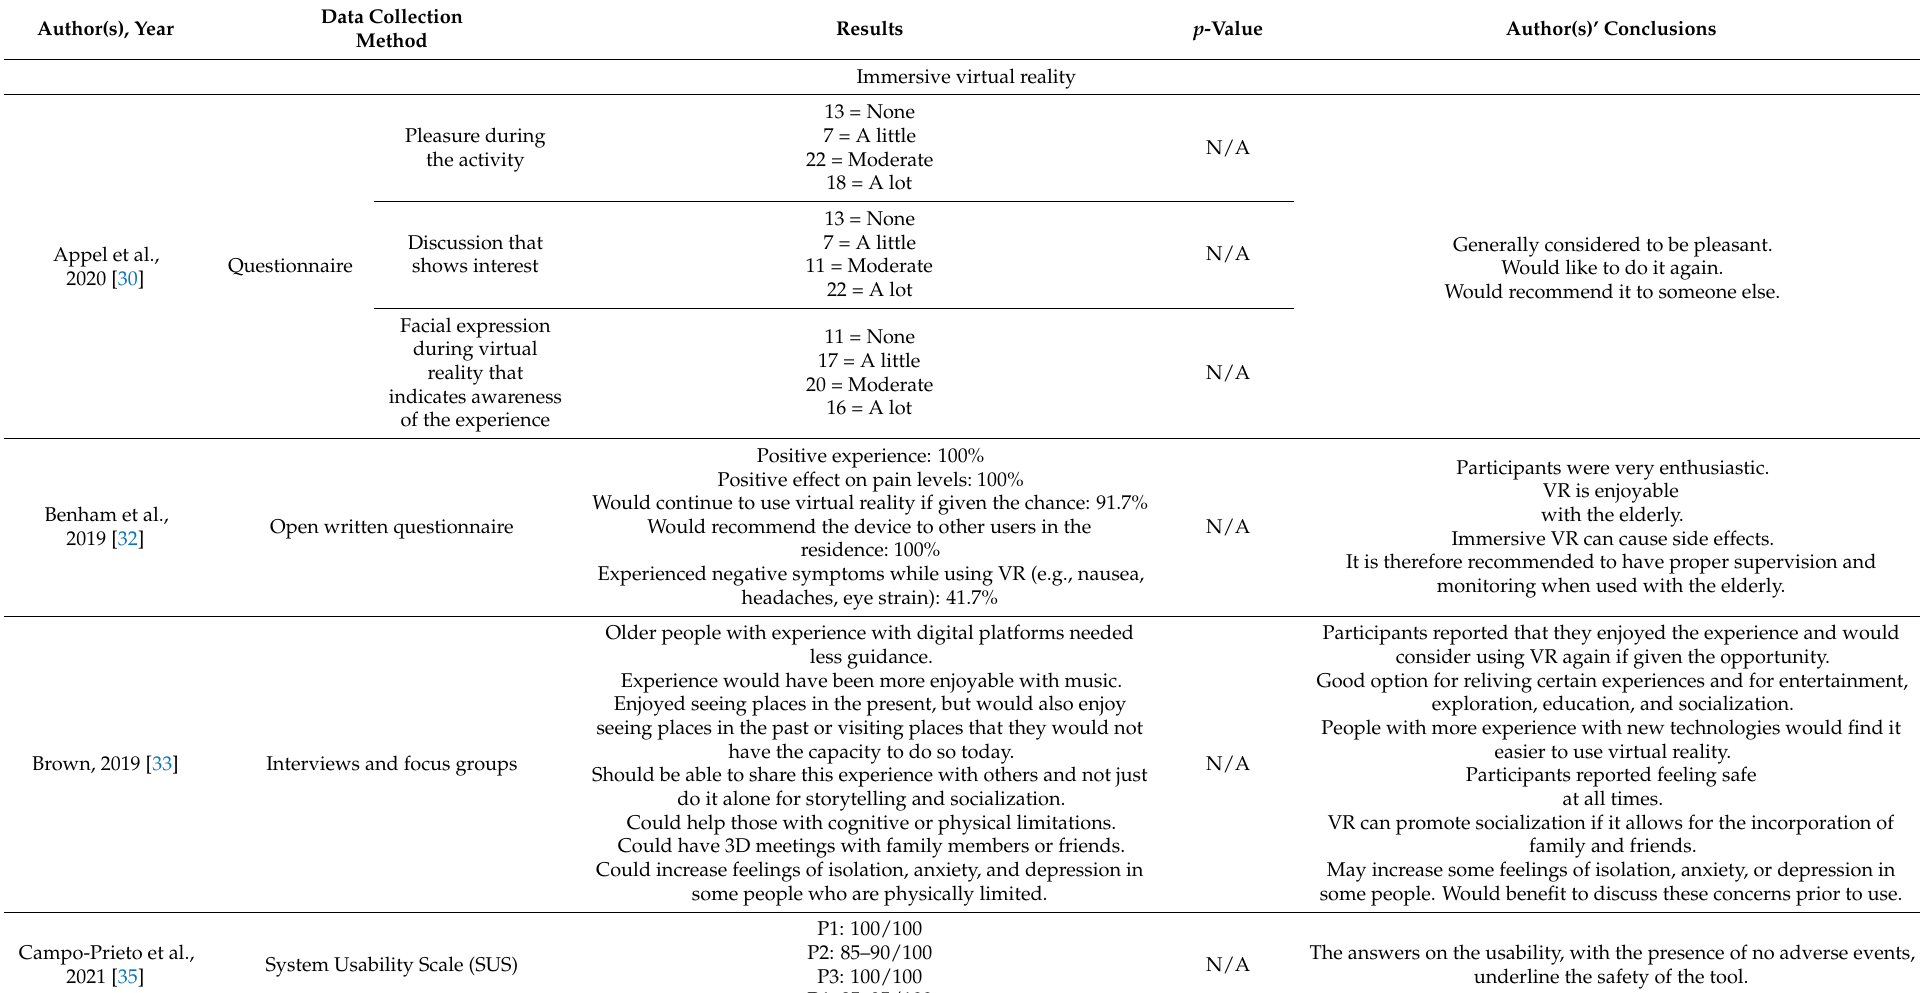
Table 5. Results and author’s conclusions on the acceptability of immersive technologies with a geriatric